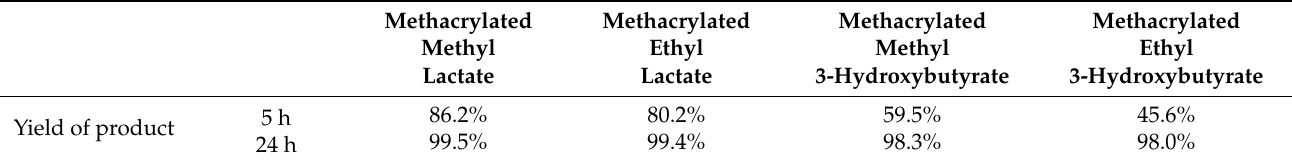
Table 4. Methacrylated alkyl ester yields compared after 5 h and 24 h of methacrylation reaction.